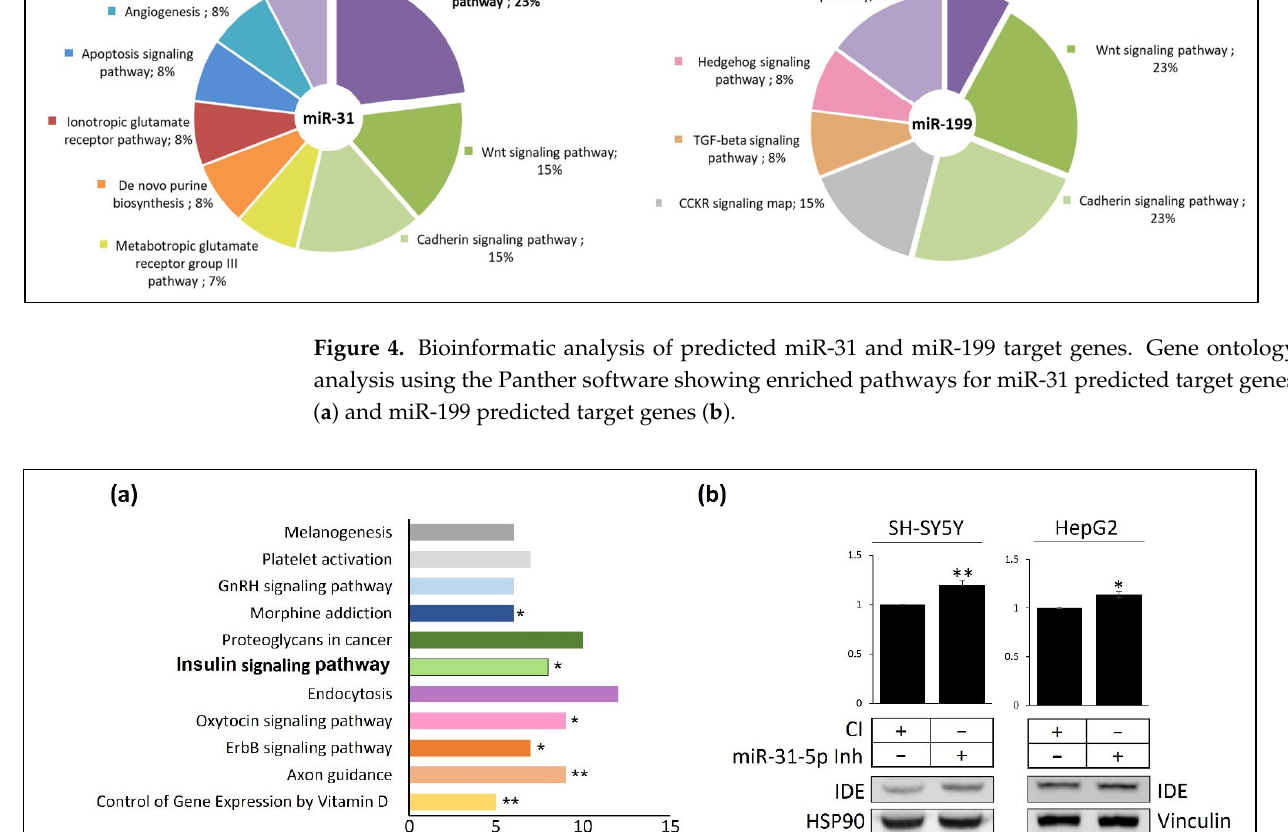
Figure 4. Bioinformatic analysis of predicted miR ‐ 31 and miR ‐ 199 target genes. Gene ontology anal ‐ ysis using the Panther software showing enriched pathways for miR ‐ 31 predicted target genes ( a ) and miR ‐ 199 predicted target genes ( b ).